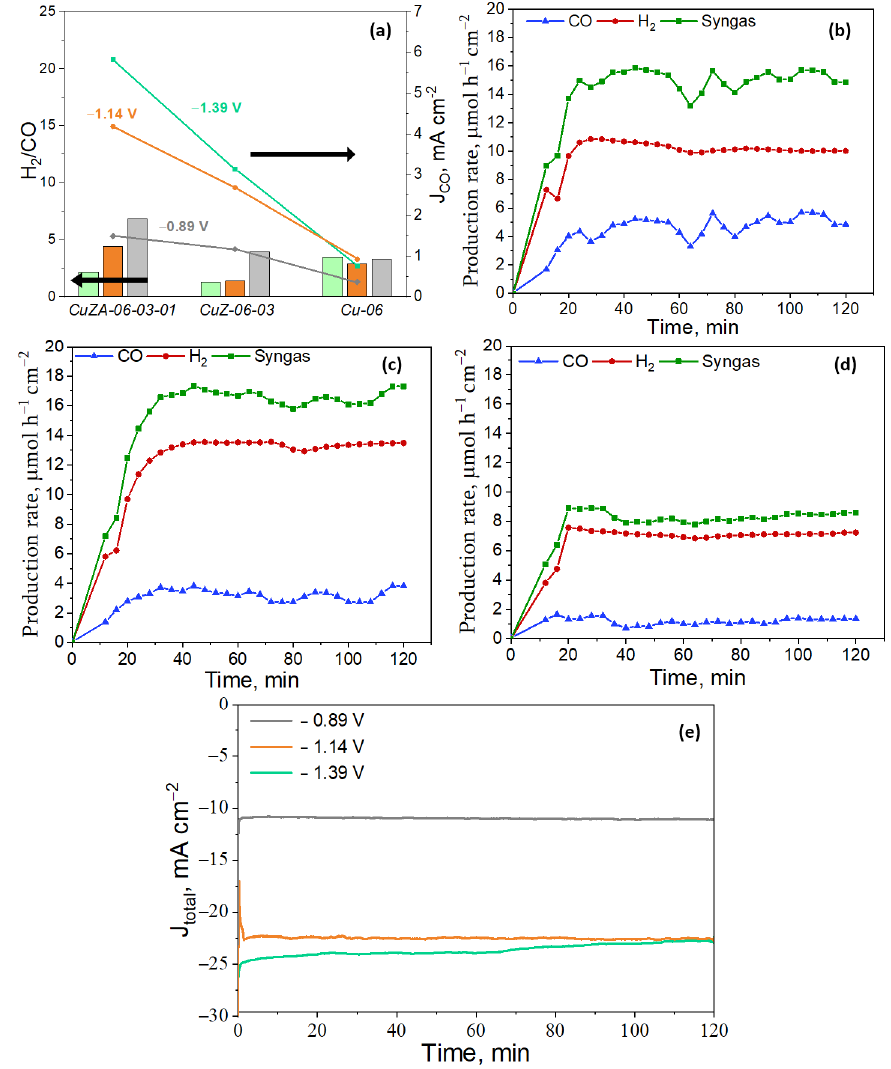
Figure 13. ( a ) H 2 /CO ratio and the corresponding CO current density (J CO ) at different applied potentials of the CuZnAl-oxide based electrodes, the black arrows indicate that bars belong to the H 2 /CO ratio axis and the lines belong to the Jco axis. Production rates of H 2 and CO on the CuZA- 06-03-01 electrode at different applied potentials: ( b ) − 1.39 V; ( c ) − 1.14 V; and ( d ) − 0.89 V vs. RHE. ( e ) Evolution time of the total current density of the ER-CO 2 on the CuZA-06-03-01 electrode at different applied potentials.